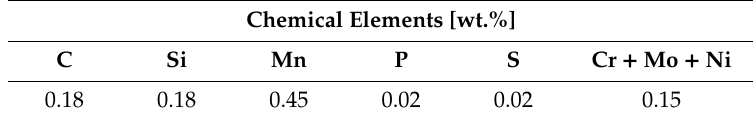
Table 1. Chemical composition of samples from steel (1.0402).